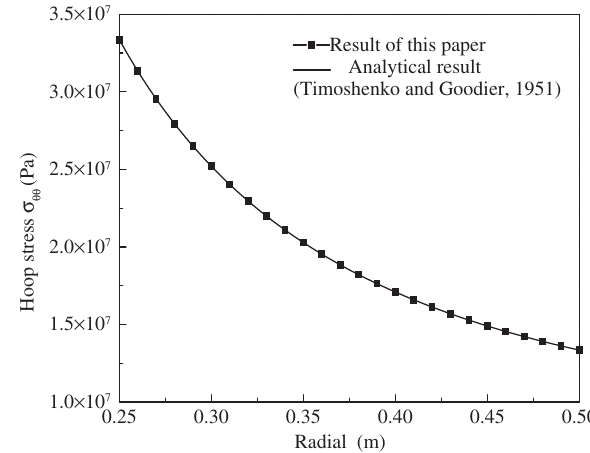
compared to analytical θθ